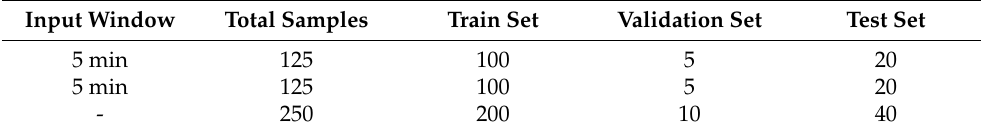
Figure 7. Illustration of signal segmentation . Table 3. Division of samples to each